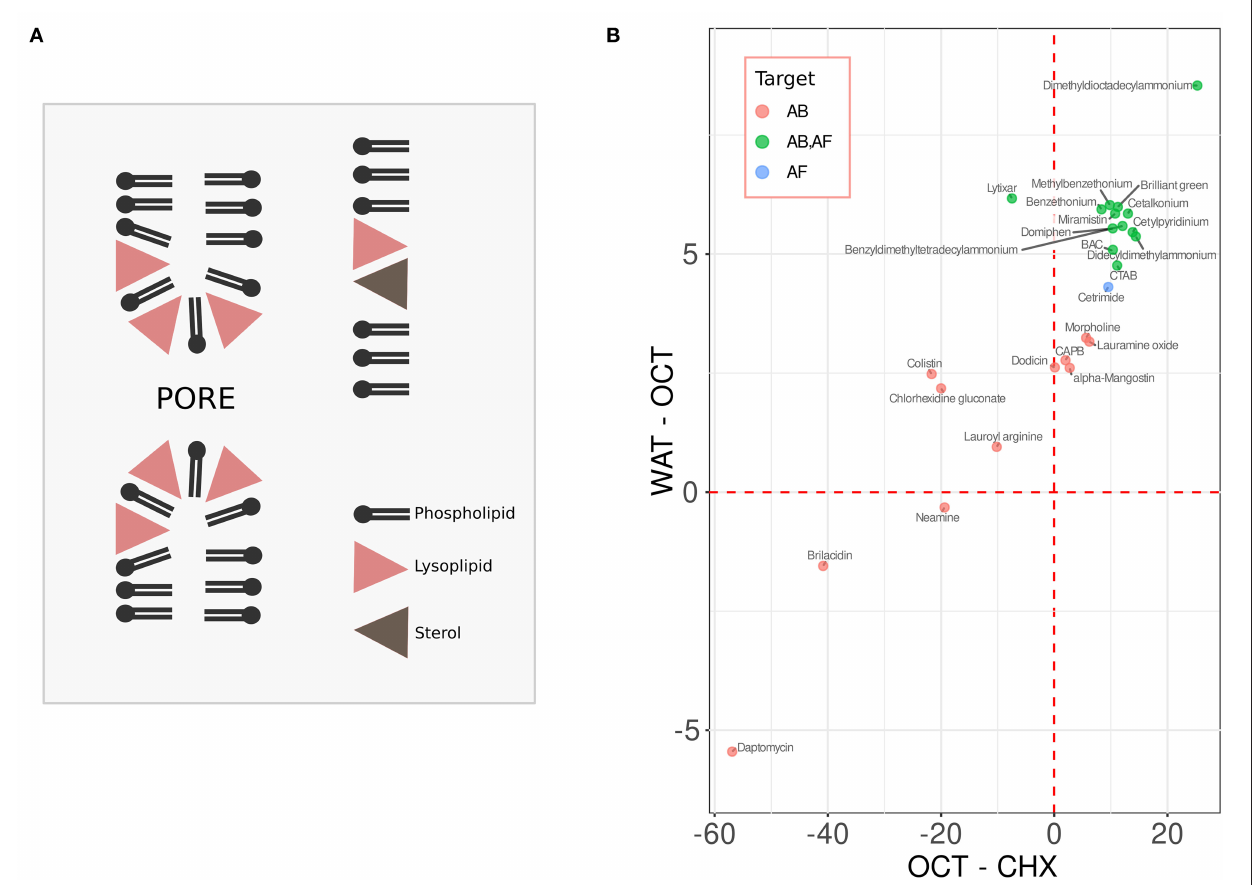
FIGURE 1 | (A) sterols protect membrane against pore formation caused by lysolipids and similar compounds. (B) the water-octanol (WAT-OCT) and the octanol-cyclohexane (OCT-CHX) change in energy of the compounds with antibacterial (AB, red), antifungal (AF, blue), and the dual activity (AB, AF, green). See text for